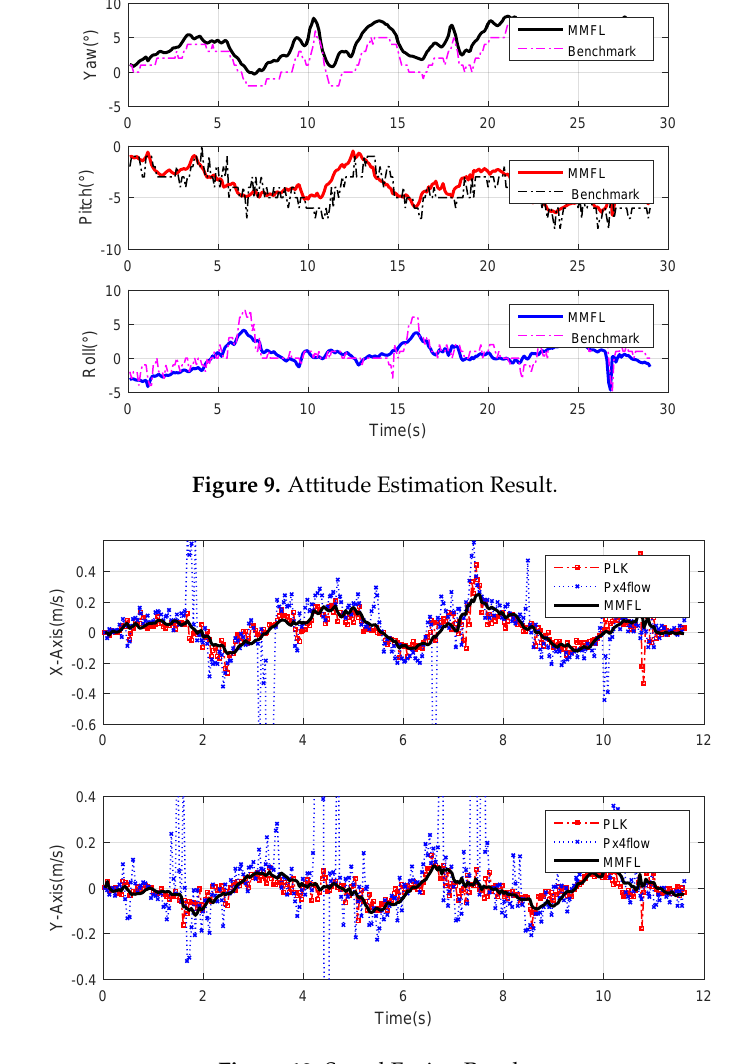
Figure 10. Speed Fusion Result.